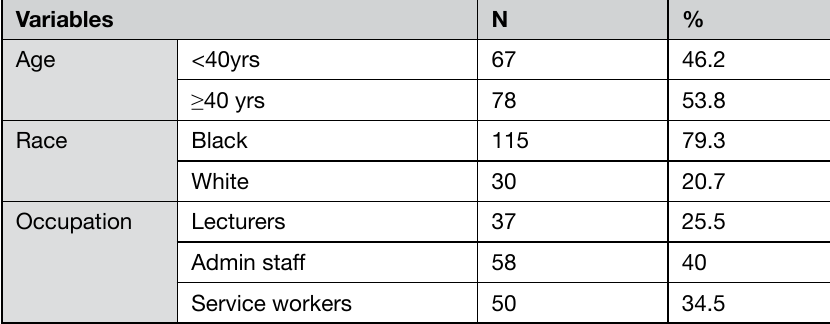
Table 1: The demographic characteristics of participants (n=145)